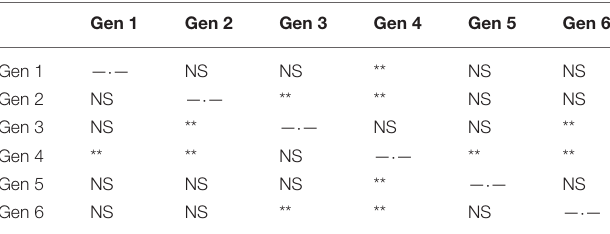
TABLE 6 | Post-hoc pair-wise comparisons for Kaplan-Meier analysis between different genotypes for low pH treatment in the long-term experiment.